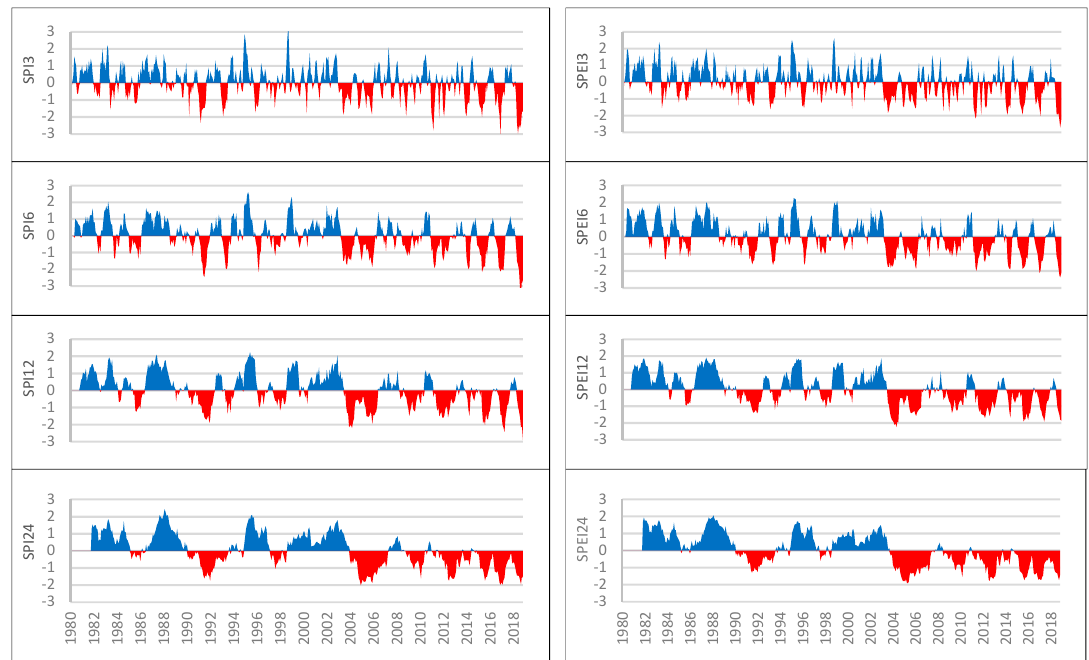
Figure 8. Drought indices SPI and SPEI for 3-, 6-, 12-, and 24 months in FIS.